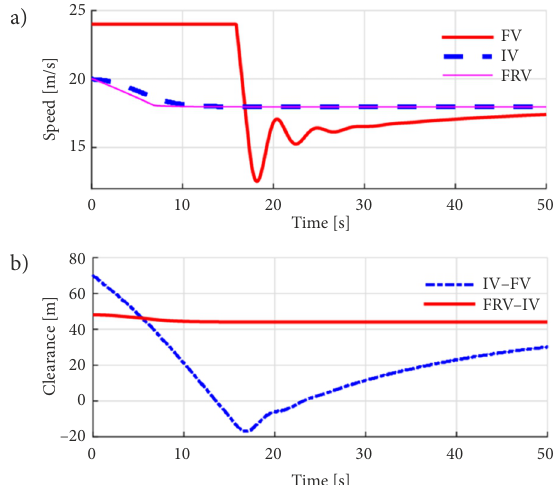
Figure 9. Vehicle speeds and clearances between vehicles (source: created by the authors): a – speeds of vehicles; b – clearances between vehicles; FV – following vehicle; IV – intelligent vehicle;